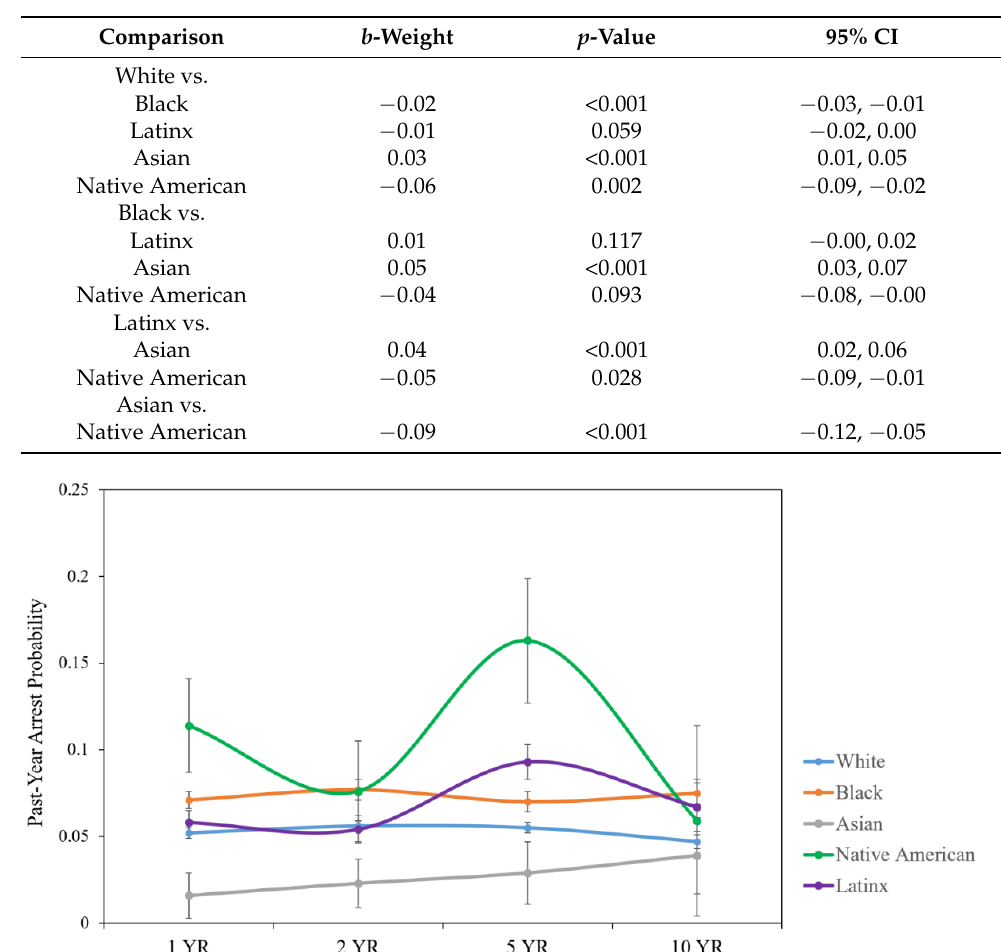
Table 3. Main effect of race/ethnicity on arrest probability trajectory.